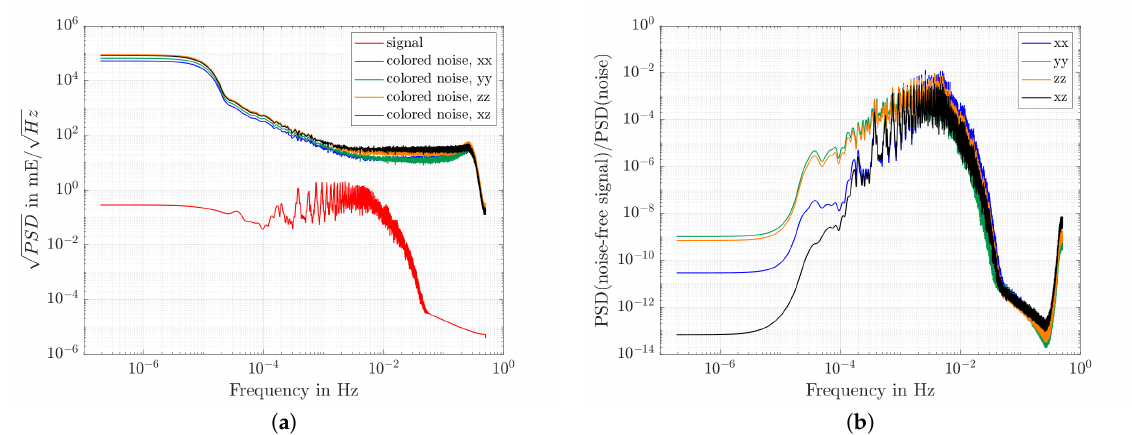
Figure 8. ( a ) Power spectral densities (PSDs) of the noise-free GRACE-based synthetic SGG data (“signal”) for the gradient component V xx and the synthetic colored noise for the four gradient components V xx , V yy , V zz and V xz . ( b ) Signal-to-noise ratio (SNR) of the four used gradient components of the synthetic data. The GOCE-like colored noise has been synthesized by using the filter models presented in Figure